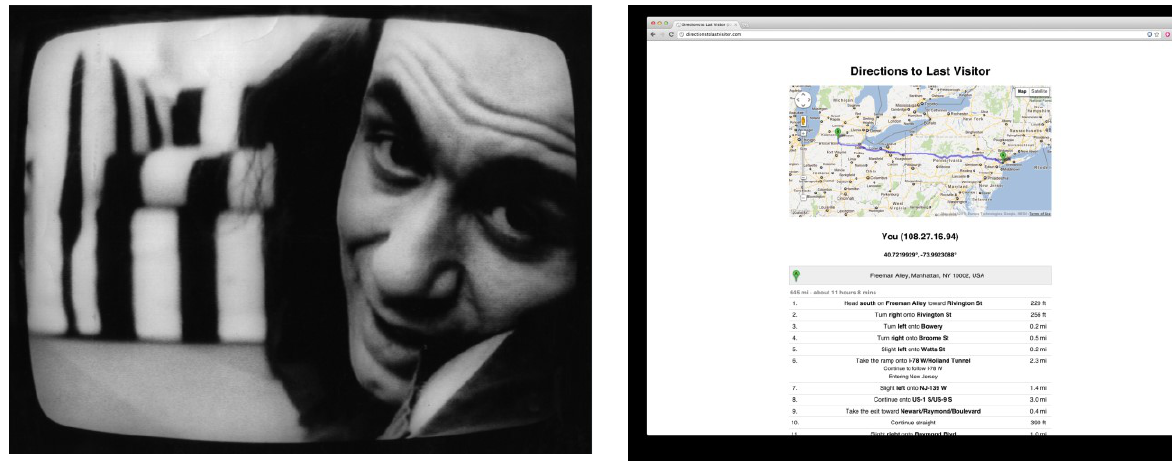
Figure 4 | Charles Broskoski, Directions to last visitor (2011). Screenshot from: http://directionstolastvisitor.com/. Courtesy of the